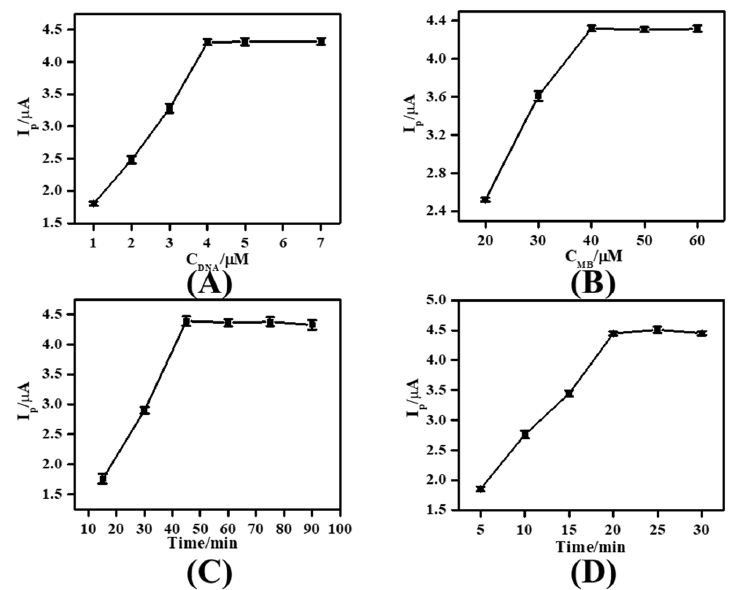
boxylated ‐ g ‐ C 3 N 4 /chitosan/GCE in 0.1 M PBS (pH = 7.4) without getting attacked by •